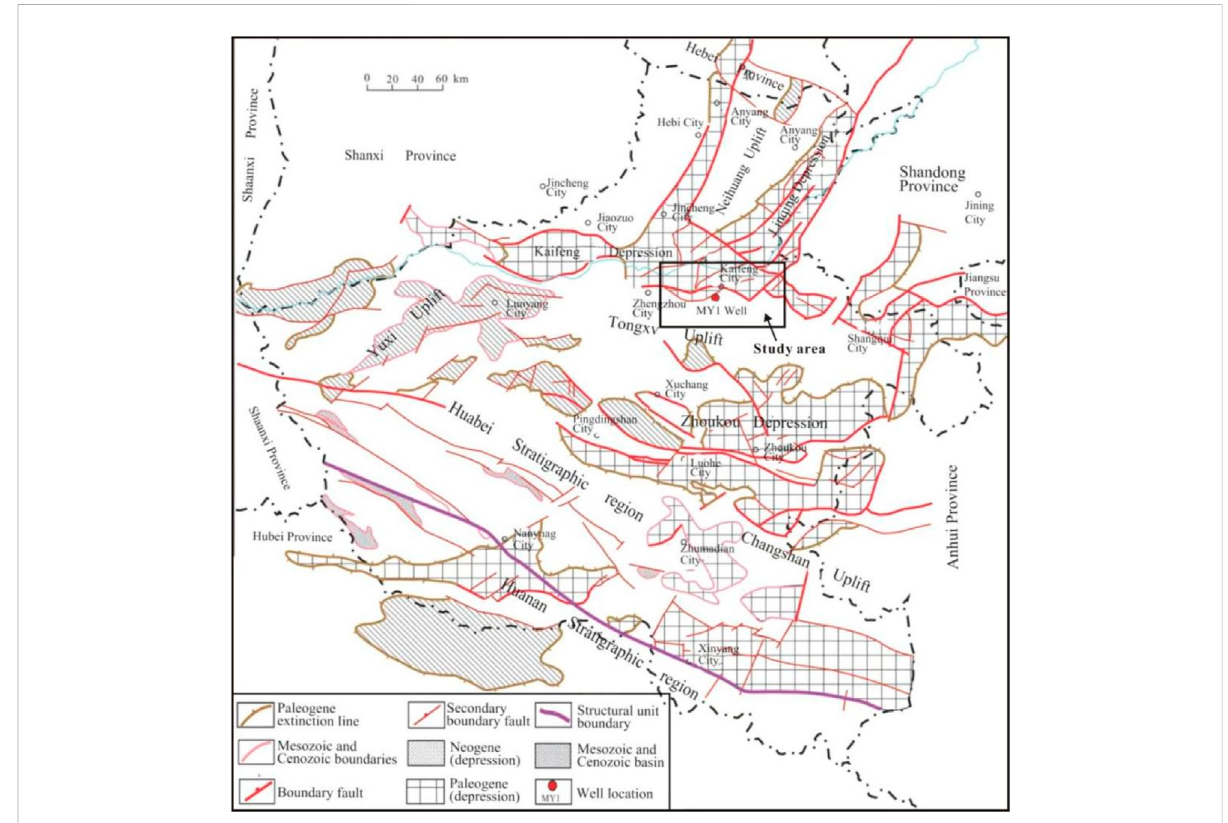
FIGURE 1 Structural unit division of the South-North China Basin and location of the study